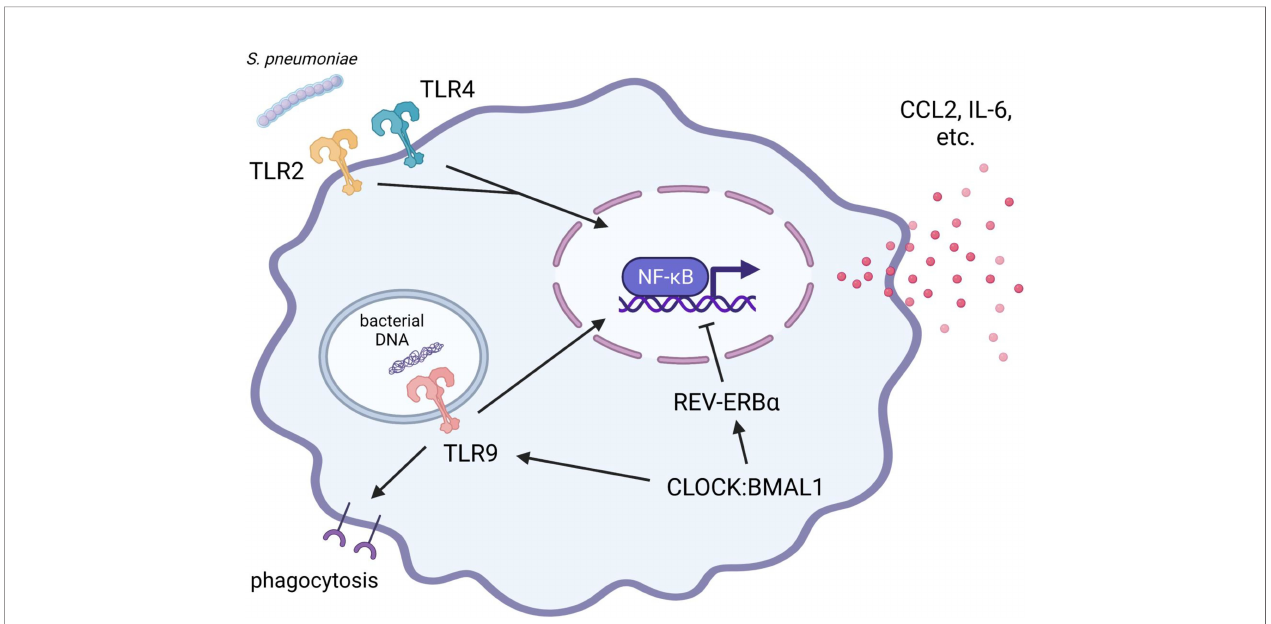
FIGURE 3 | Protective roles of TLR2, TLR4, and TLR9 during pulmonary S. pneumoniae infection: implication of the circadian clock. The pro-in fl ammatory responses via TLR2 signaling play a supporting part in eliciting local in fl ammation and bactericidal activity against S. pneumoniae . In contrast, initial pro-in fl ammatory responses via TLR4 signaling in alveolar macrophages contribute to the prompt elimination of S. pneumoniae and the prevention of life-threatening pneumonia. REV-ERB a suppresses the production of pro-in fl ammatory cytokines (such as IL-6) and chemokines (such as CCL2). TLR9 signaling is indispensable for upregulating the phagocytic activity of alveolar macrophages to prevent systemic transmission of S. pneumoniae . The expression and function of TLR9 are positively regulated by the CLOCK : BMAL1 heterodimer. Therefore, since the pro-in fl ammatory responses of alveolar macrophages are complexly and precisely controlled by clock components, the disruption of circadian rhythms may lead to diminished ability to eliminate bacteria and consequent exacerbation of pneumonia. BMAL1, brain and muscle ARNT-like 1; CCL2, C-C motif chemokine ligand 2; CLOCK, Circadian locomotor output cycles kaput; IL-6, interleukin 6; TLR, toll-like